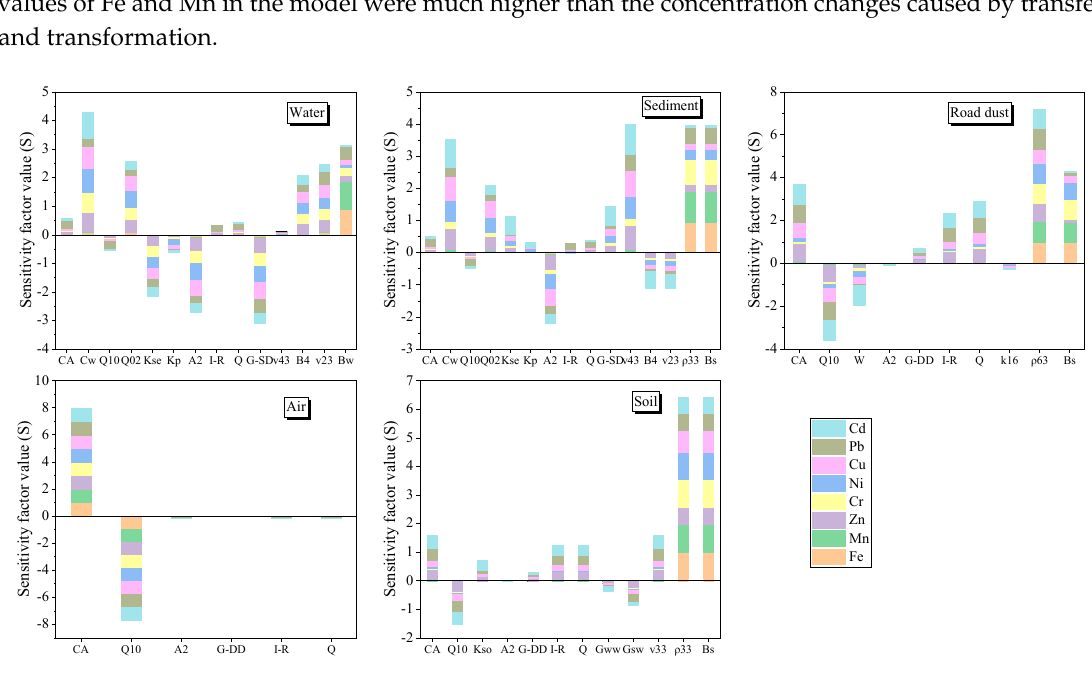
Figure 5. The sensitivity coefficients for the parameters.